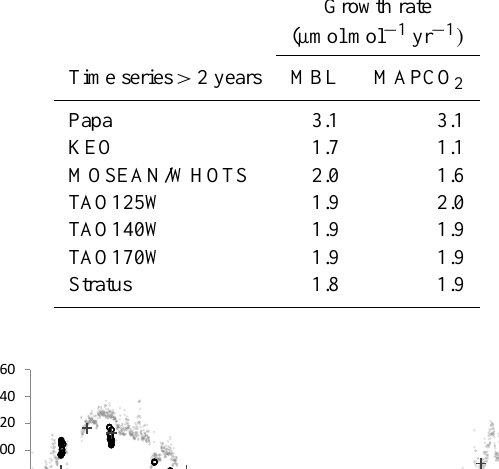
Table 4. Growth rate of GLOBALVIEW-CO2 MBL and MAPCO 2 atmospheric x CO 2 time series over the time period of the data sets listed in Table 5 (GLOBALVIEW-CO2, 2013). For mooring time series locations see Fig. 3.